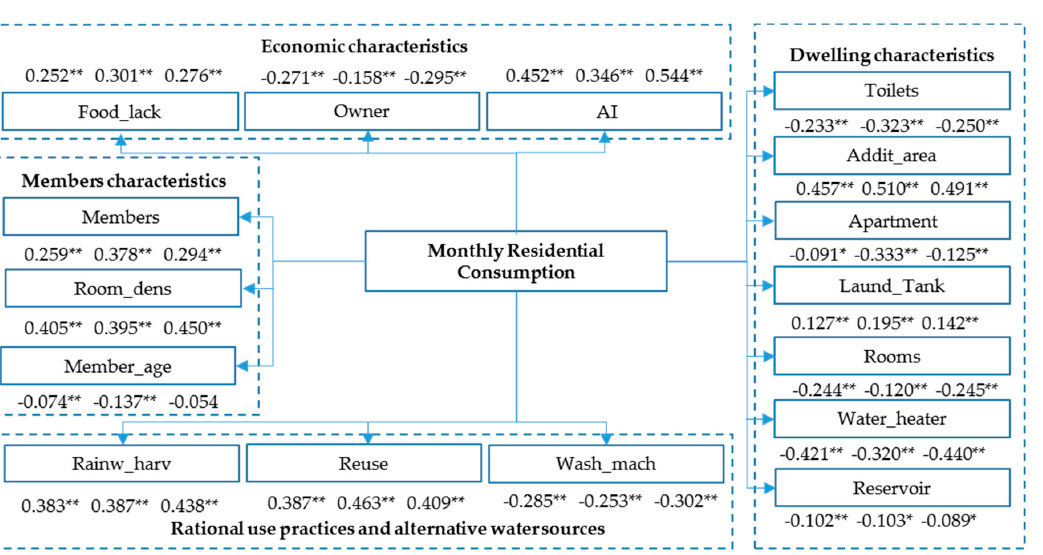
Table 5. Specifications of the linear regression models.